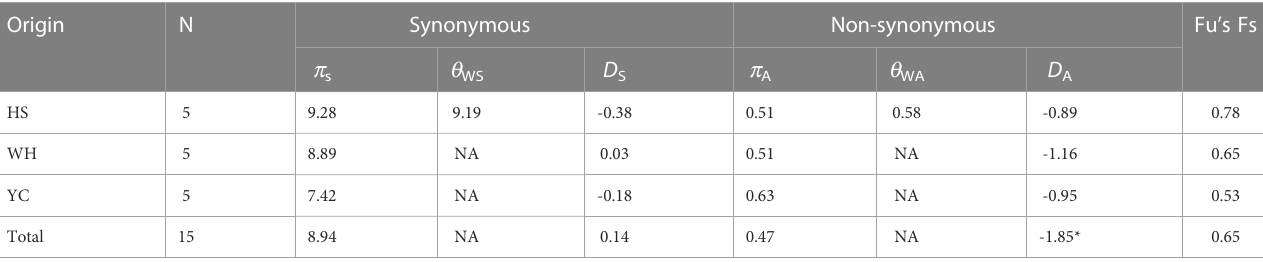
TABLE 4 Nucleotide diversity, Tajima ’ s D, and Fu ’ s Fs based on Rpb1 of Neo fl abelliforma dubium n. sp.